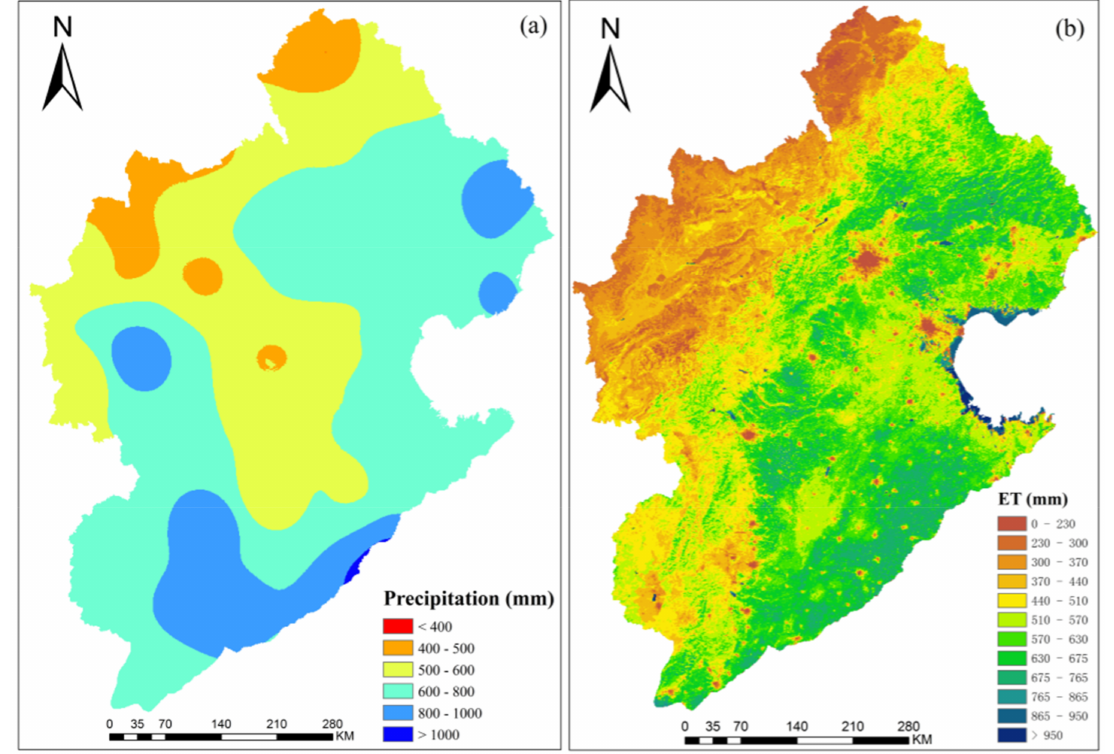
Figure 7. Spatial distribution of ( a ) the annual precipitation and ( b ) annual ET over the Hai River Basin for 2016.